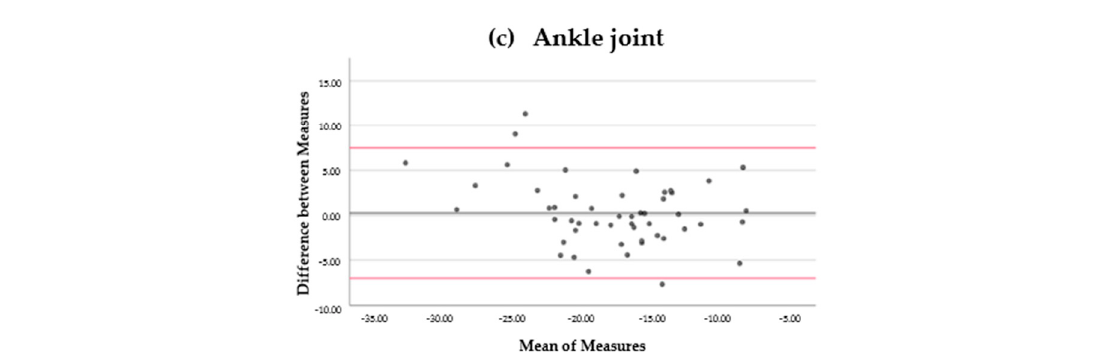
Figure 2. Bland–Altman plots. Difference between measurements for hip angles ( a ), knee angles ( b ), and ankle angles ( c ) during toe-off. Bias (black line) and limits of agreement (red lines) are indicated. The mean score is shown on the x -axis, and the difference between measures (and the mean of the differences) is shown on the y -axis (mean difference ± 1.96 SD).